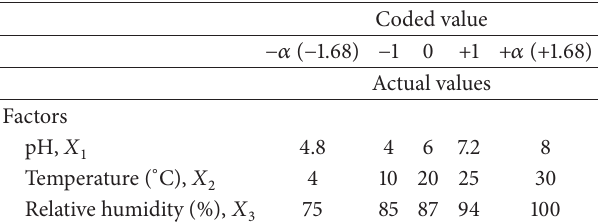
Table 1: Coded and actual values for independent factors ( 𝑋 1 , 𝑋 𝑋 2 , 3 ) with 5 levels used in the experimental (central composite rotatable (CCRD))